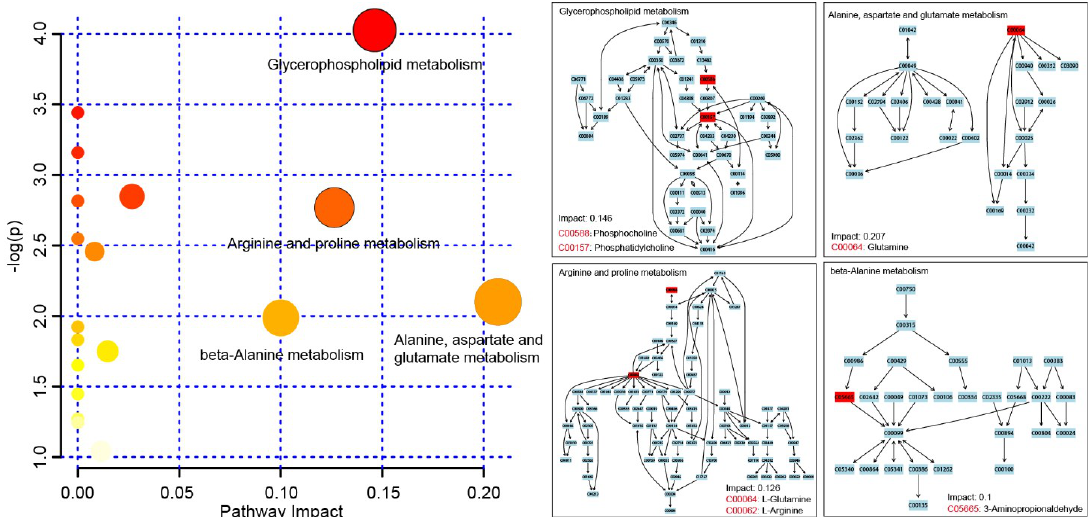
Figure 4. Metabolic pathway analysis of the 34 differentially changed metabolites. The identified metabolic pathways were visualized and arranged according to the score based on enrichment analysis (y-axis) and topology